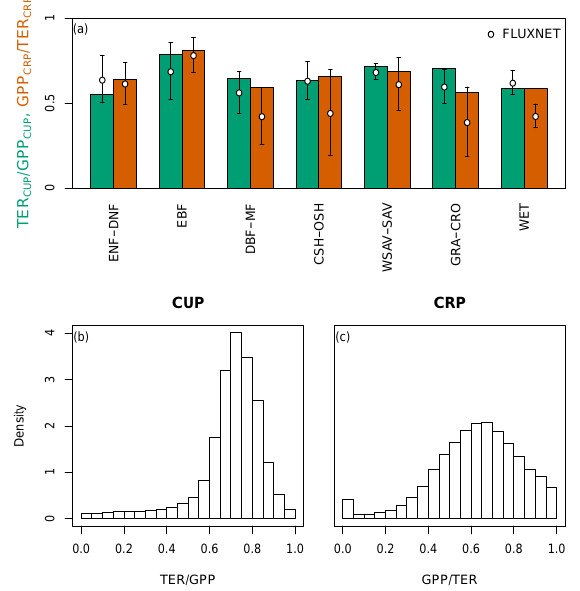
Figure 8. Bar plot of the TER / GPP ratio for the CUP (green bars, a ) and of the GPP / TER ratio during the CRP (red bars, a ); these values were calculated for the MPI-MTE product; dots refer to FLUXNET sites. Averages of yearly values are represented together with their standard deviation. The global frequency distributions of the ratios obtained from the MPI-MTE product are shown in the histograms (b, c) at the